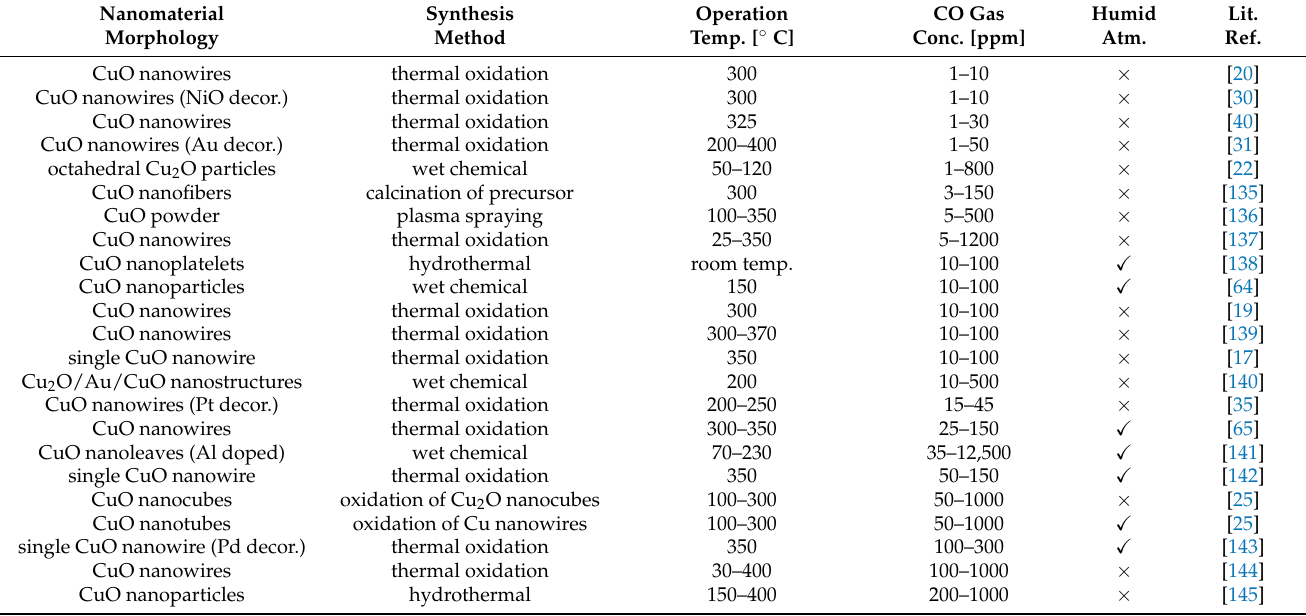
Table 3. A summary of sensing carbon monoxide (CO) with copper oxide-based devices.